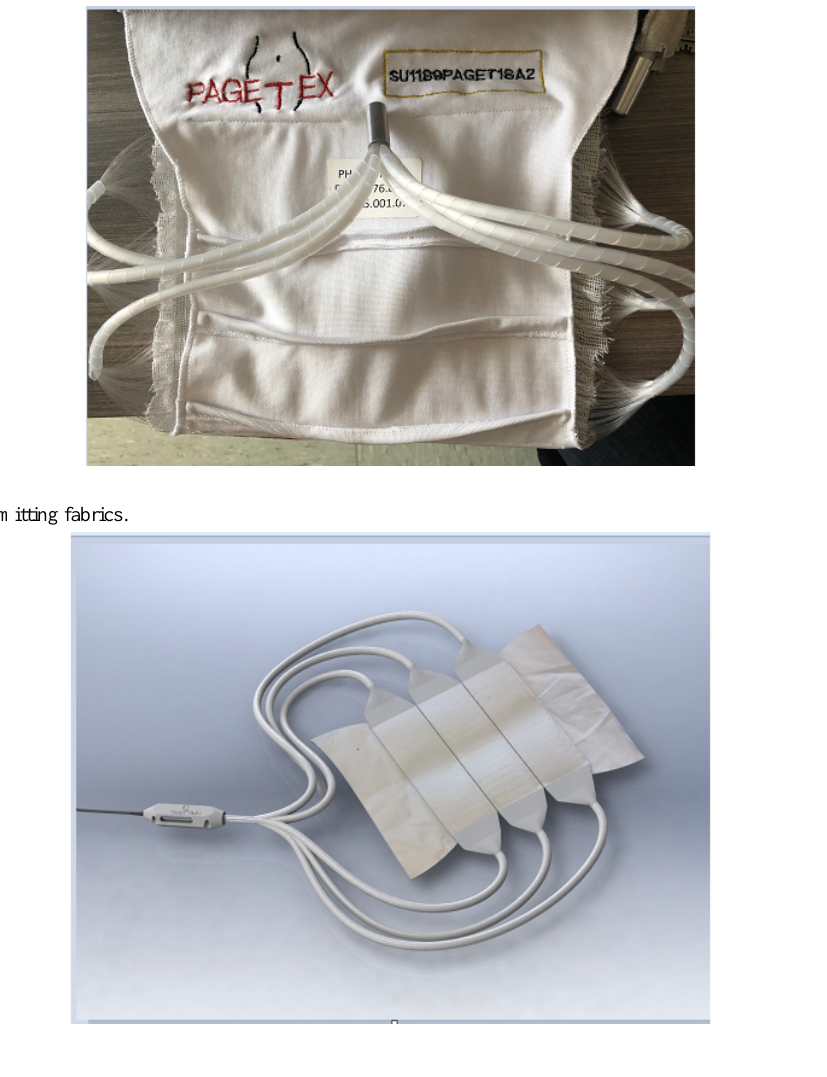
Figure 1. PAGETEX light diffuser support.